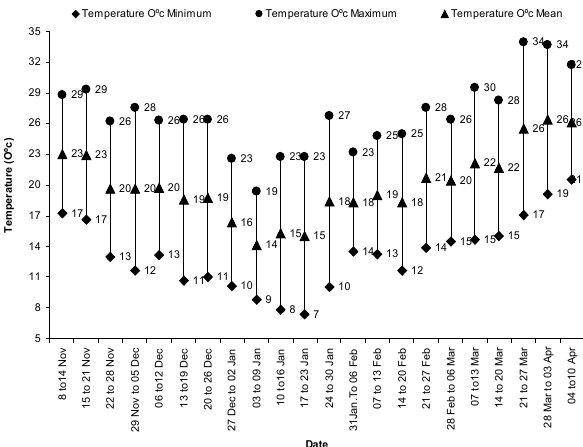
30°C, while the minimum temperature was between 12 and 13°C, in OS. However, at LS, the average maximum and minimum temperatures were near 23 and 10°C, and